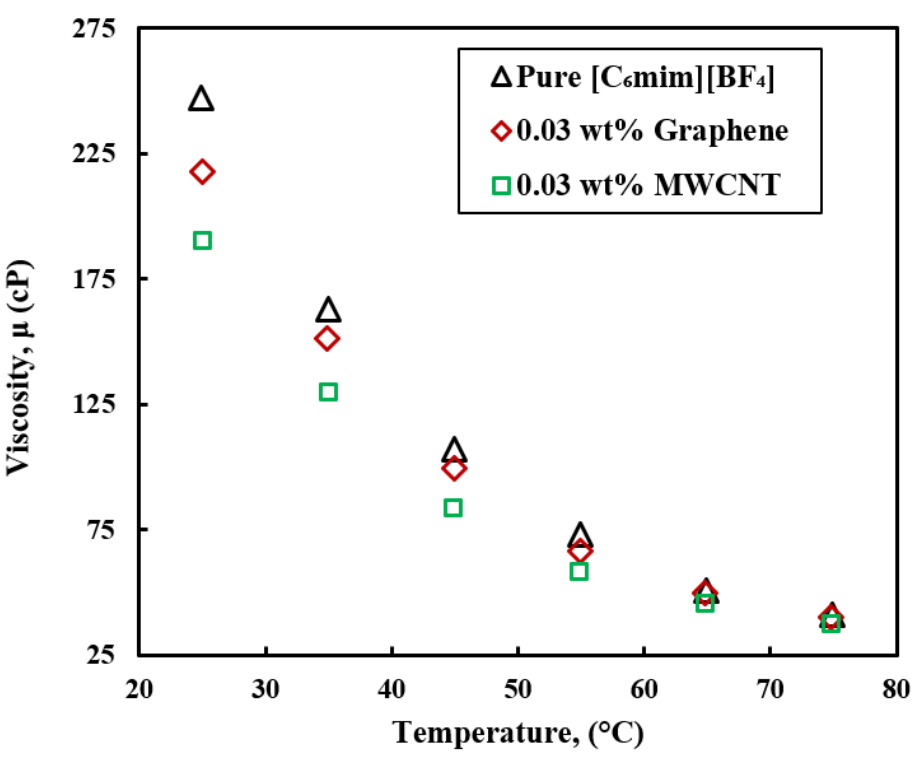
Figure 17. Effect of GE and MWCNTs nanoparticle on the viscosity of [C 6 mim][BF 4 ] as a function of temperature[53]. Reproduced with permission from F Wang, Nanoscale research letters; published by [Springer], 2012 .